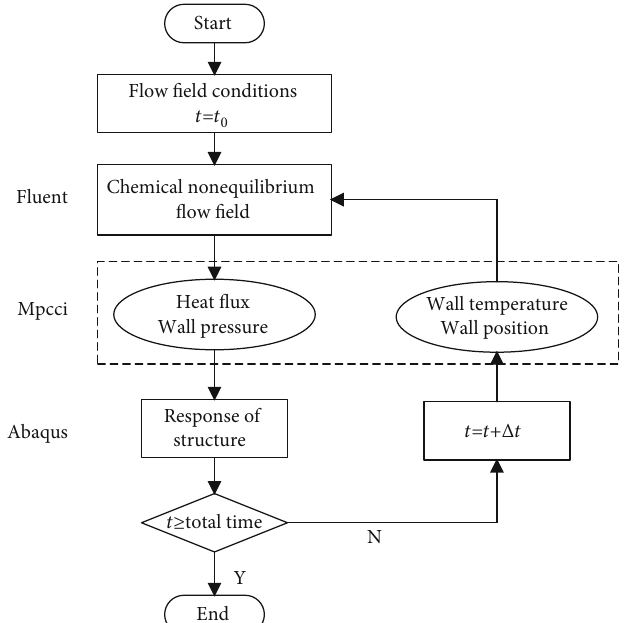
Figure 4: Fluid-thermal-structural coupling process.